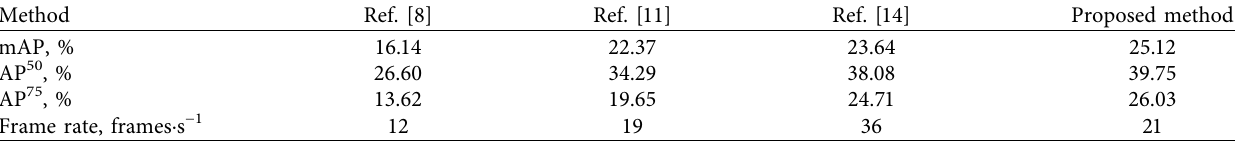
Table 5: Comparative experimental results of different detection methods on UAV aerial photography